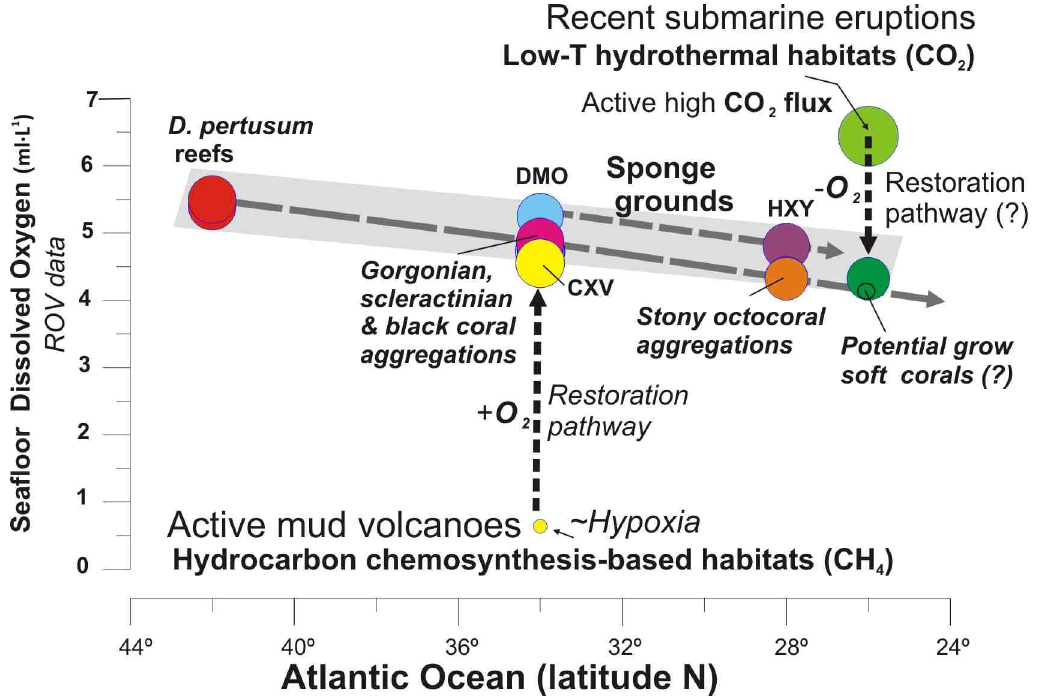
Figure 16. Seafloor dissolved oxygen values vs. latitude for each deep-sea habitat. Grey pattern shows the oxygen threshold for CWC reef and gardens, and deep-sea sponges along the northeast Atlantic Ocean. Dashed black lines show the potential pathways from conditions of cold seeps and recent submarine eruptions to be suitable for non-chemosynthesis-based habitats according the level of dissolved oxygen on the benthic layer. Data are fully listed in Supplementary Table S3.